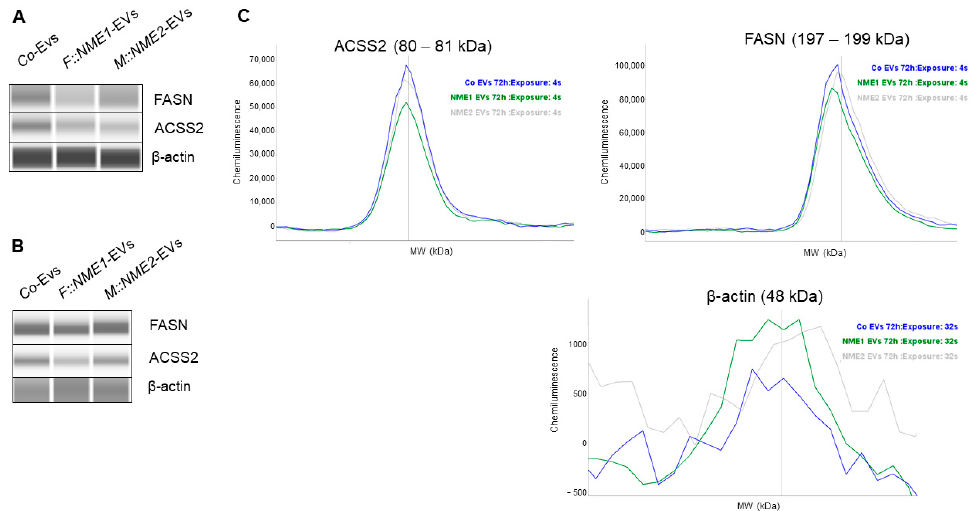
Figure 5. FASN and ACSS2 protein levels are decreased in normal skin fibroblasts after NME1- EV and NME2-EV treatments . Normal skin fibroblast cells were treated with a mixture of sEVs and mEVs derived from the supernatant of the three different transfected MDA-MB-231T cell lines: F::NME1, M::NME2 and Co, respectively. ( A ) After a 24 h incubation, fibroblasts were lysed, and protein extracts were prepared. Cell lysates were immunodetected by WES TM Simple capillary im- munoassay system. A decreased FASN and ACSS2 protein level was observed in fibroblasts treated with either NME1-EVs or NME2-EVs compared to the control condition. ( B ) In another experiment, fibroblasts were treated 3 times (0, 24, 48 h) with sEVs and mEVs derived from the supernatant of the three transfected MDA-MB-231T cell lines. After 72 h, cell lysates were collected and analysed by WES TM . ( C ) Corresponding electropherograms of WES TM analysis on panel ( B ) also show that multiple NME1-EV and NME2-EV treatments resulted in decreased FASN and ACSS2 levels com- pared to the Co condition, analysed by WES TM after 72 h.